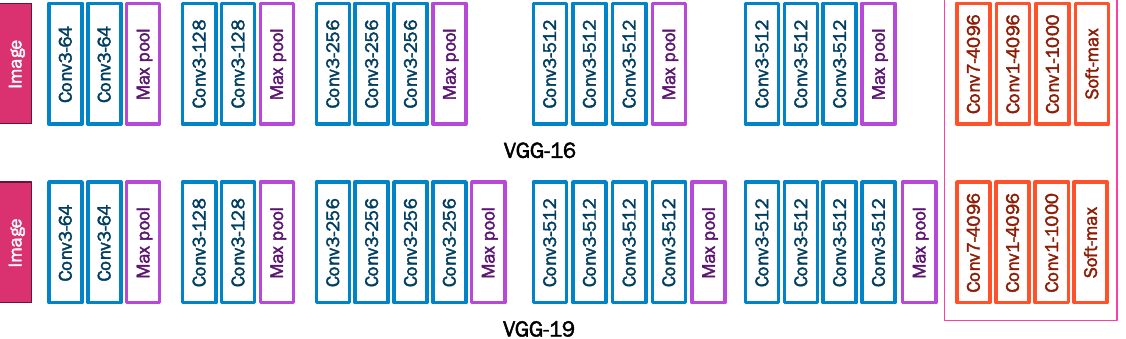
Figure 4. VGG-16 and VGG-19 architecture. ResNet model: It is a type of advanced convolutional neural network; this model was proposed by Kaiming He in his 2016 document [42]. The ResNet-50 version consists of 50 layers. This model is based on the idea of residual and identity blocks that use skip con- nections (shortcut) (Figure 5), where the input is passed to a deeper layer. In other words, the simple deep convolutional neural network is inspired by VGG with 3 × 3 filters and a ReLU activation function, which is modified to become a residual network by adding skip connections to define residual blocks. On the top, the architecture contains a fully con- nected output layer with a softmax activation function for classification. Figure 6 shows the general configuration of the residual network architecture, including ResNet-50, Res- Net-101, and ResNet-152.